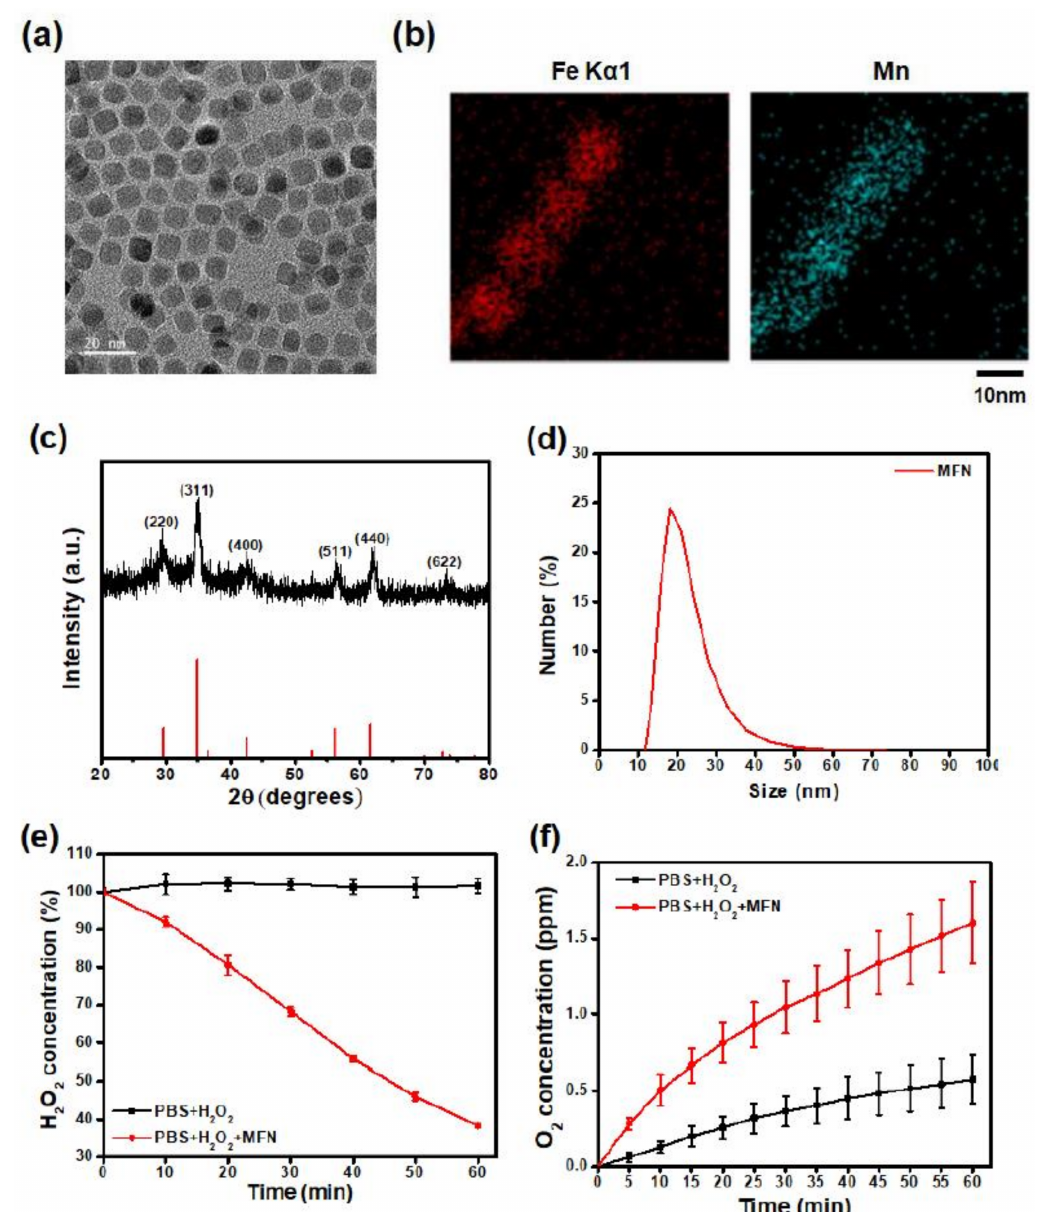
Figure 1. Synthesis of MnFe 2 O 4 nanoparticles (MFN) and evaluation of their ability to degrade H 2 O 2 and generate oxygen. ( a ) Transmission electron microscopy image of MFN. Scale bar: 20 nm. ( b ) Energy dispersive spectroscopic analysis of MFN. ( c ) X-ray diffraction pattern of MFN. ( d ) Hydrodynamic size distribution of MFN after PEGylation. ( e ) Decomposition of H 2 O 2 by MFN via Fenton reaction. ( f ) Oxygen generation after treatment with